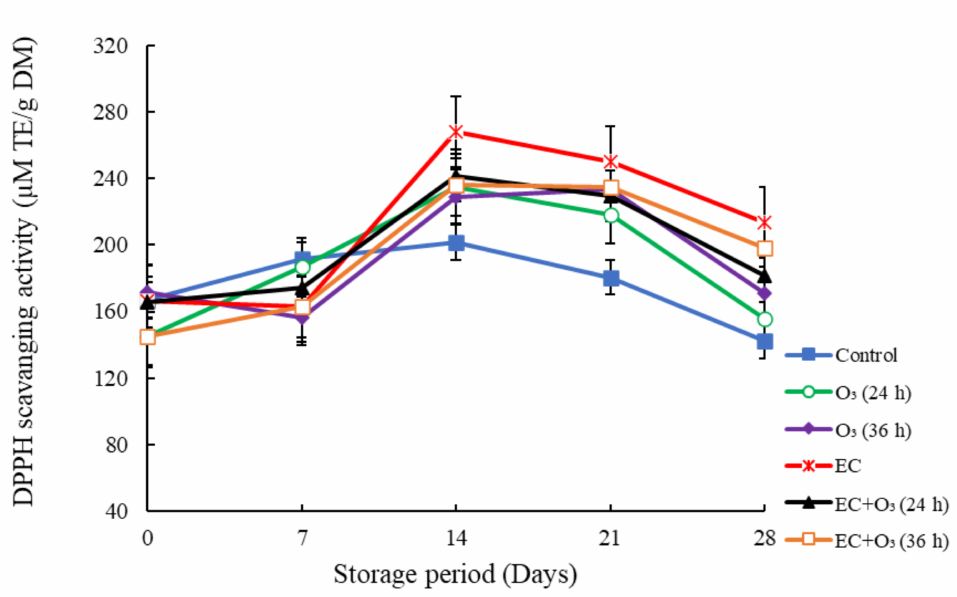
Figure 2. Effect of edible coating (EC) and gaseous ozone (O 3 ) on DPPH scavenging activity of mango peel during storage at 10 ◦ C for twenty-one days and shelf-life at ambient temperature for seven days ( ± SE, n = 9).